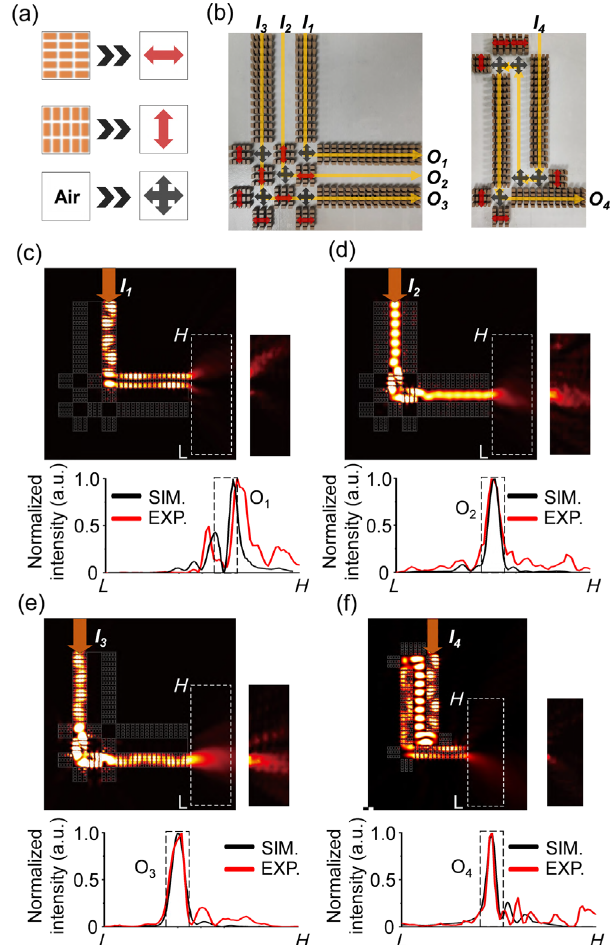
FIG. 5. Numerical and experimental demonstrations for sharp- bending and routing photonic circuits. (a) The PC or free-space supercells allow transmission in the x or y directions or both directions. (b) Left: photo of the experimental sample of the 90° bending arrays. There are three transmission paths from I i to O i ( i ¼ 1 , 2, 3). Right: photo of the experimental sample of the routing circuit. The transmission path is from I 4 to O 4 . (c) – (f) The simulated (upper panel, left) and measured (upper panel, right) intensity patterns under independent excitation from the input ports I i ( i ¼ 1 , 2, 3, 4). The white dashed frame marks the experimentally measured regions. The lower panels show the normalized intensity distributions on the left edge of the mea- sured